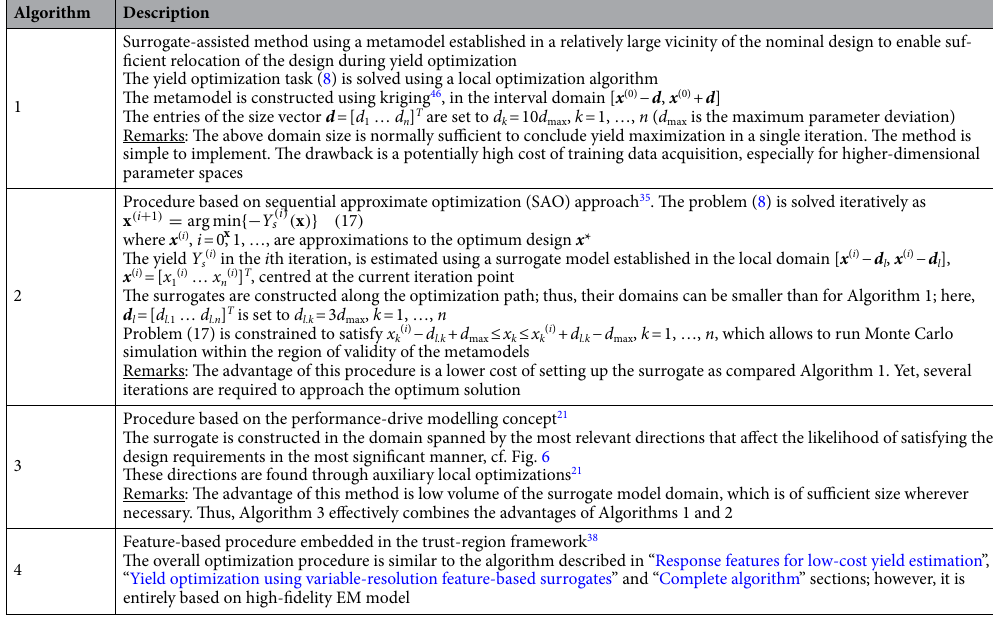
Table 2. Benchmark